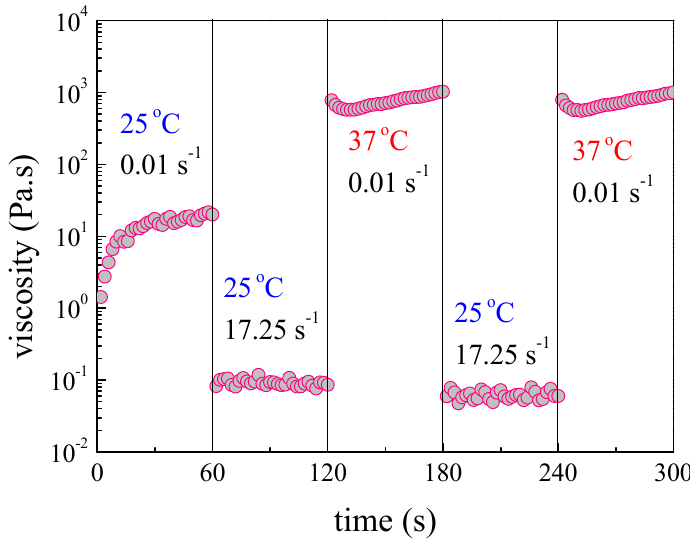
Figure 5. Shear viscosity versus time of a 5 wt% NaALG-g aqueous solution without the presence of nanoparticles at different shear rates 0.01 s − 1 (at 25 °C), 17.25 s − 1 (at 25 °C) and 0.01 s − 1 (at 37 °C) and conversely.